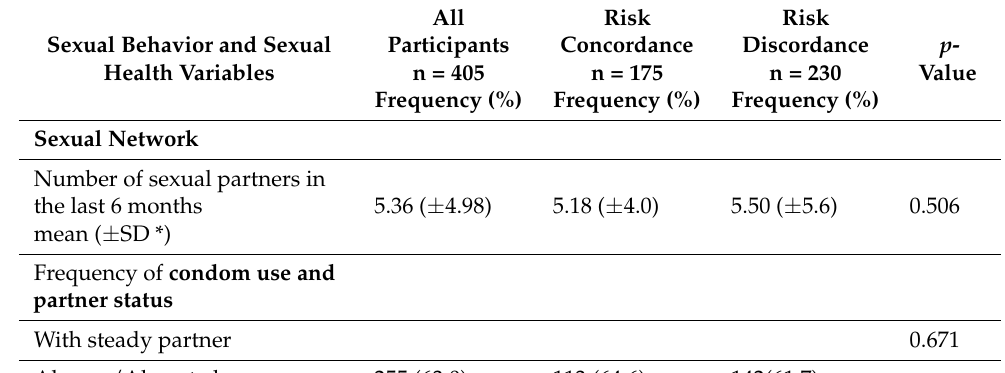
Table 2. Sexual behavior and sexual health based on the absence or presence of HIV risk discordance. p -values from Student’s t-test for continuous variables and chi-squared test for categorical